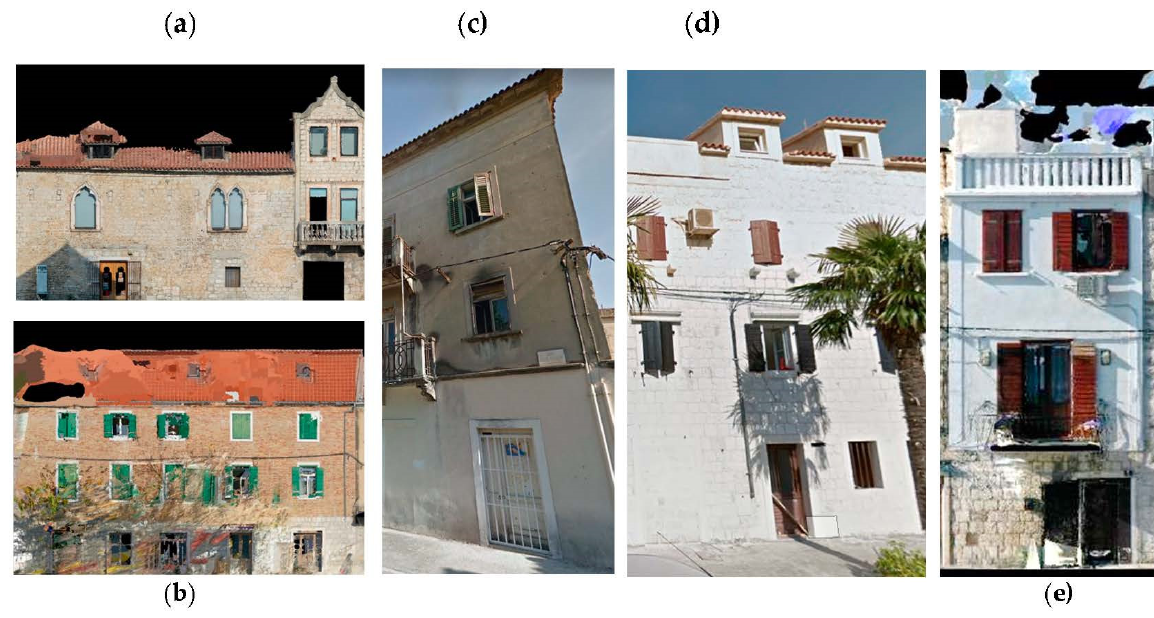
Figure 8. Selected five buildings for the Kaštela study area. Elevations photographed or reconstructed by photogrammetry.